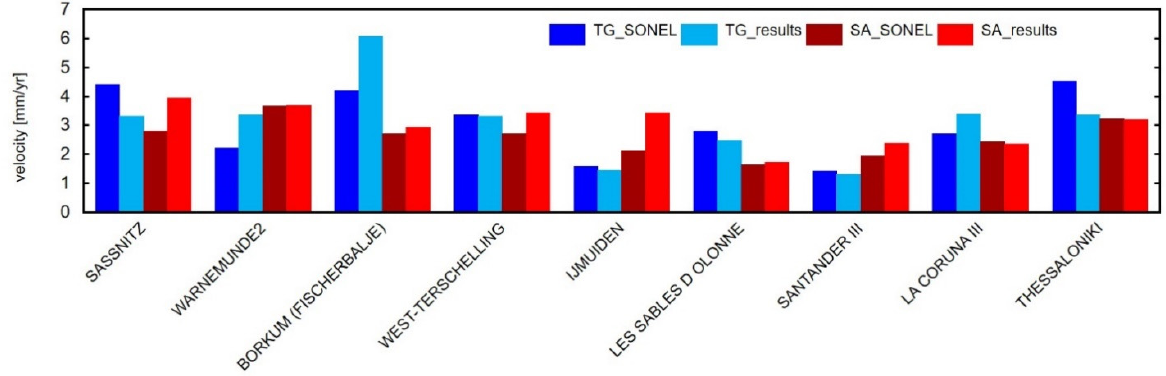
Figure 17. A comparison of the velocity estimated in nine European coastal zone stations and SONEL stations based on TG and SA time series.